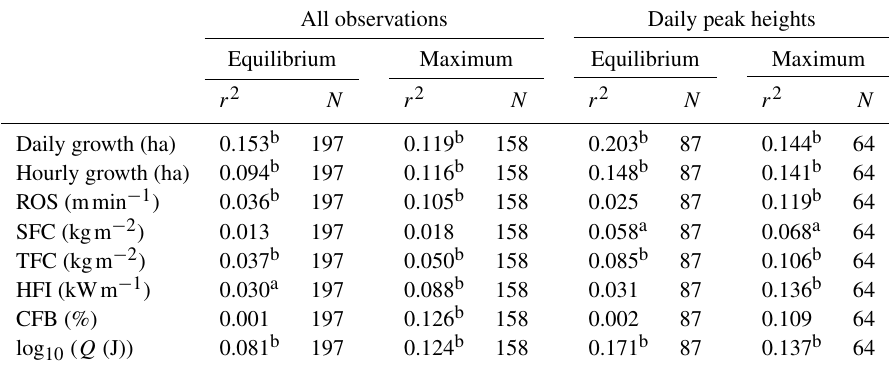
Table 6. Correlation of fire behaviour and observed plume heights.